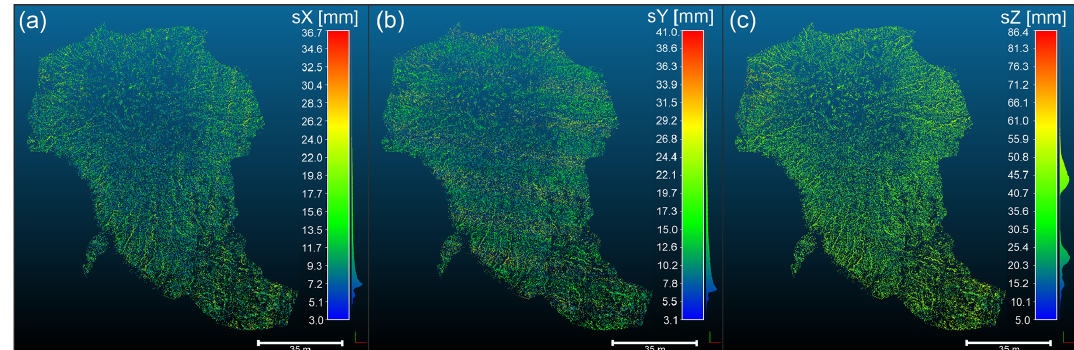
Figure 8. 3D error estimates of each point of the sparse cloud of the 13 September 2019 survey. The error (sX, sY, sZ) is in millimeters. (a) and (b) The horizontal errors ( X and Y component) are shown. (c) The vertical errors ( Z component) are shown. The reference system is WGS 84/UTM zone 33N.